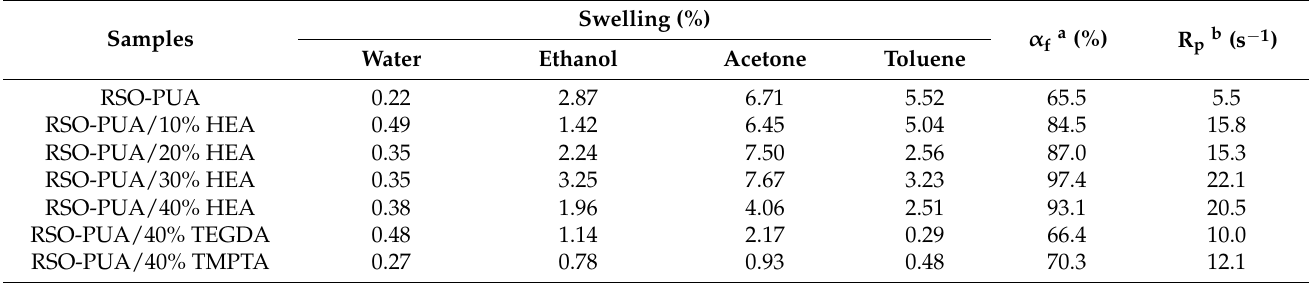
Table 4. Swelling properties and UV-curing behaviors of the cured RSO-PUA